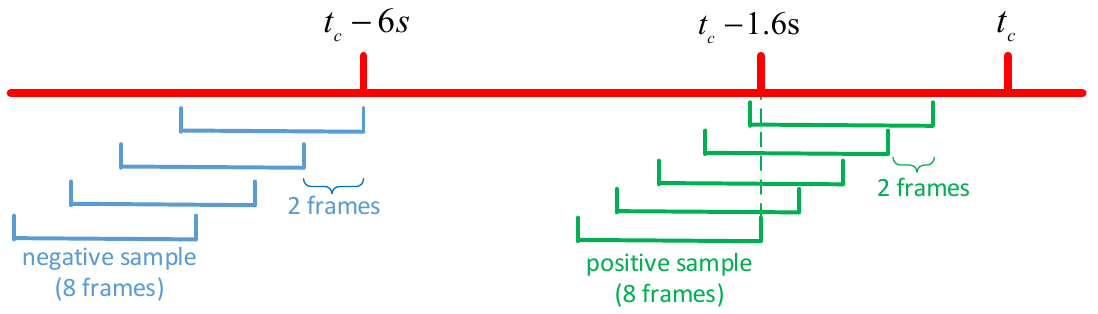
Figure 11. Schematic diagram of experimental sample extraction. Where t c represents the time when pedestrians begin to cross the street. The red line indicates the time line of pedestrian crossing behavior. The green and blue lines represent the extracted positive and negative samples, respectively.